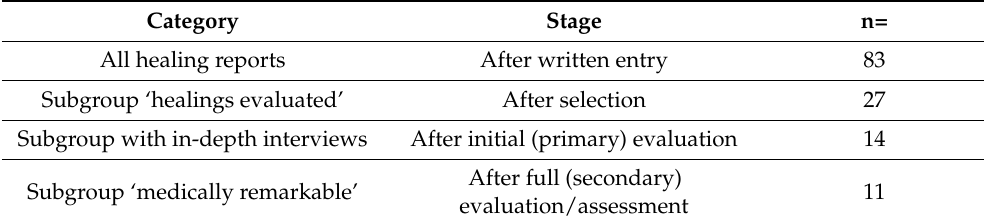
Table 1. categories of cases after selection and evaluation/assessment.